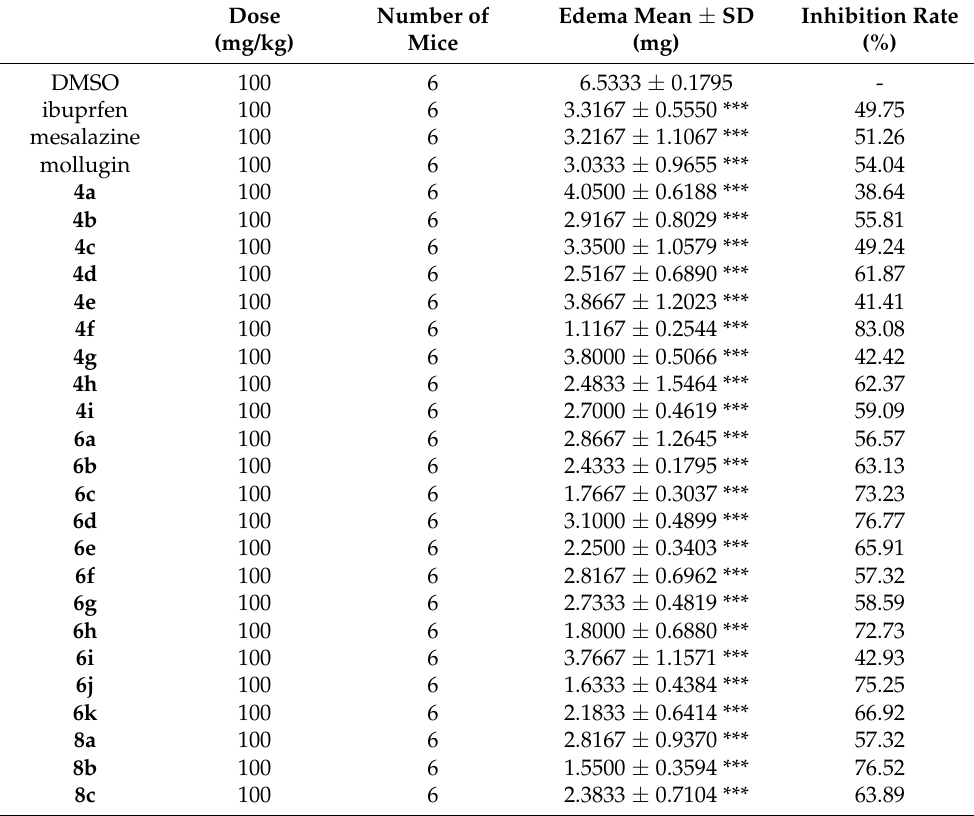
Table 4. In vivo anti-inflammatory activity of compounds 4a–i , 6a–k , and 8a–c administrated i.p.